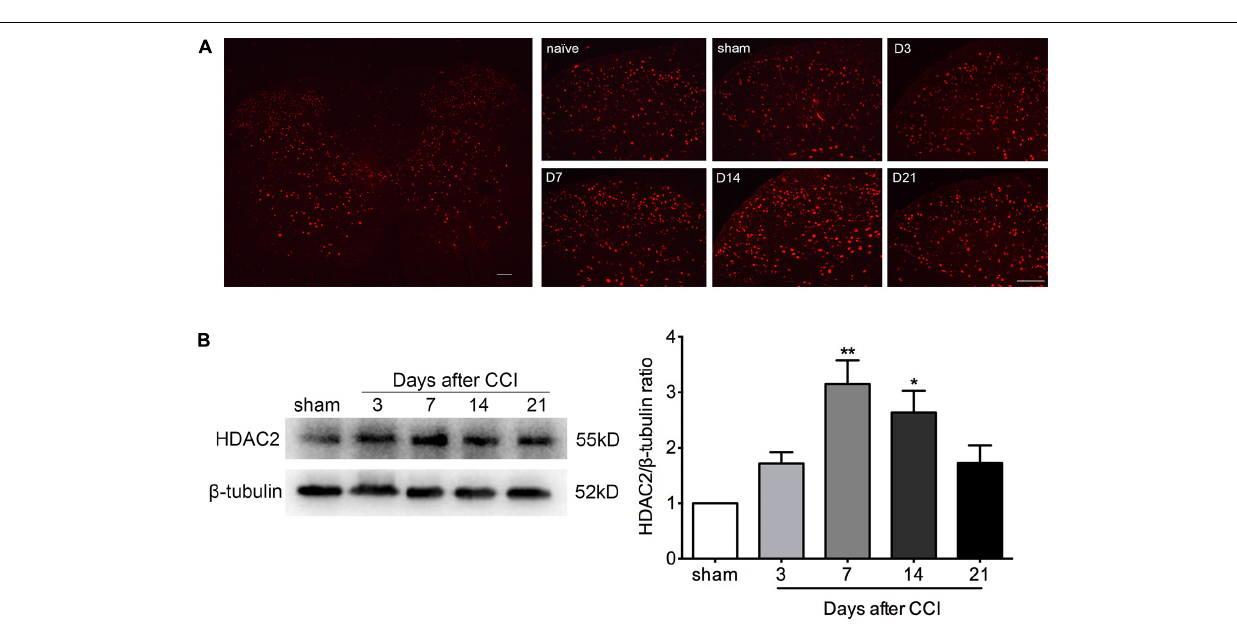
FIGURE 2 | HDAC2 expression was enhanced in a time-dependent manner in the lumbar spinal cord of CCI rats. (A) Immunofluorescent signal of HDAC2 (red) detected in the whole lumbar spinal cord section and the ipsilateral dorsal horn of rats. D3: 3 days after CCI; D7: 7 days after CCI; D14: 14 days after CCI; D21: 21 days after CCI; scale bar = 100 µ m. (B) Western blot analysis showed that HDAC2 protein levels were altered in a time-dependent manner. A significant increase was detected on days 7 and 14 after CCI; n = 4 per group, ∗ p < 0.05, ∗∗ p < 0.01, compared to the Sham group.